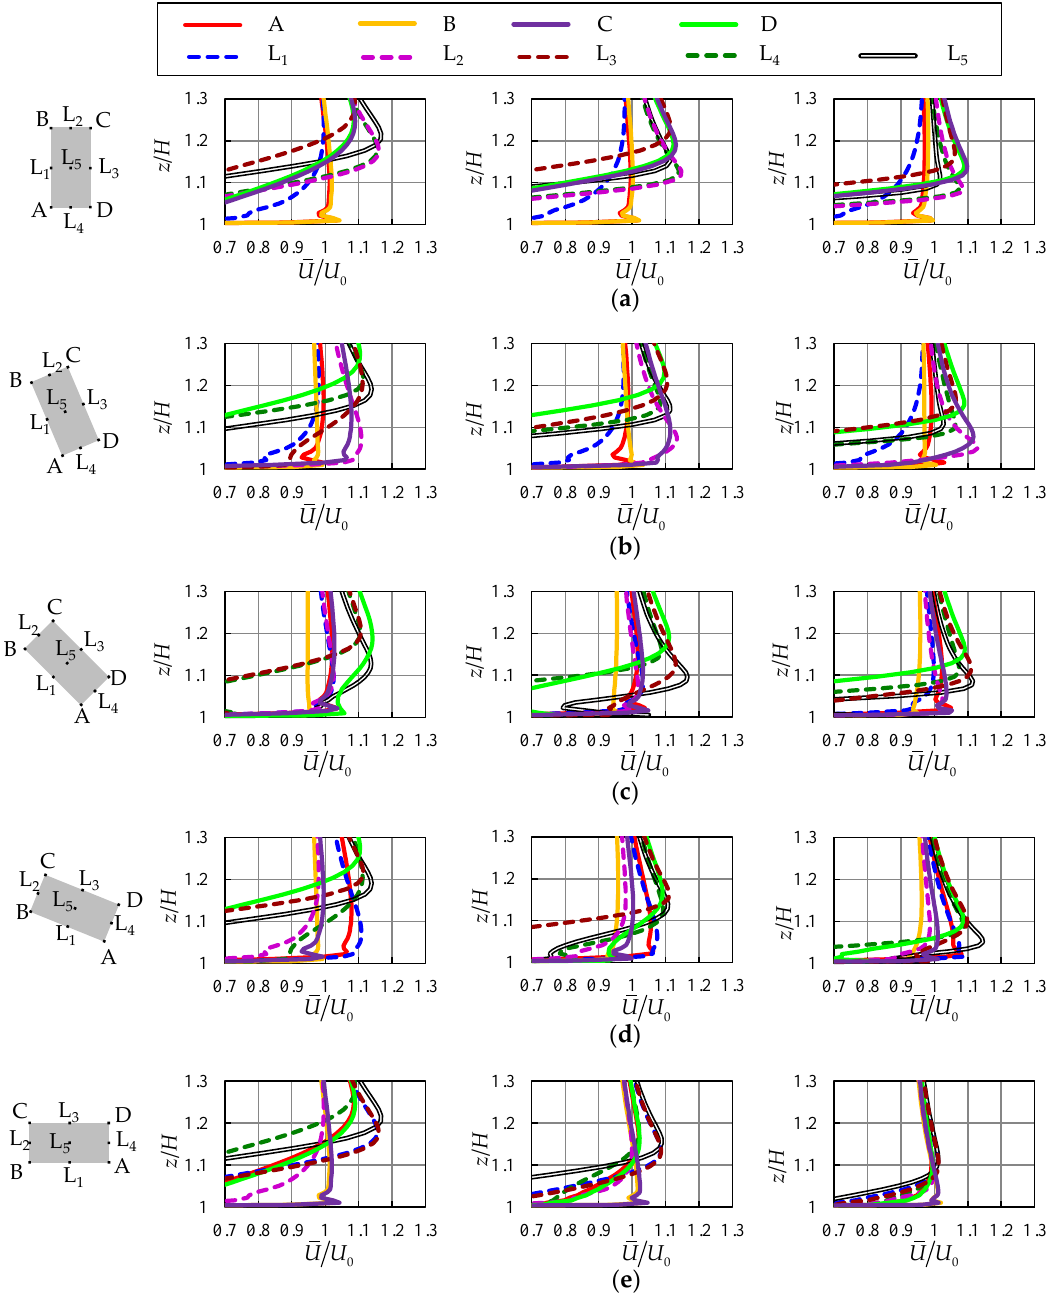
Figure 9. Vertical profiles of horizontal wind velocity ratios at the representative locations on the roof: HAR = 1.00 ( left ), HAR = 0.50 ( middle ), HAR = 0.25 ( right ). ( a ) α = 0°; ( b ) α = 22.5°; ( c ) α = 45°; ( d ) α = 67.5°; ( e ) α = 90°. In ( d , e ), the graphs of HAR = 1.00 are obtained by editing the results of cases 100_225 and 100_000, respectively, to facilitate the comparison of different HARs.